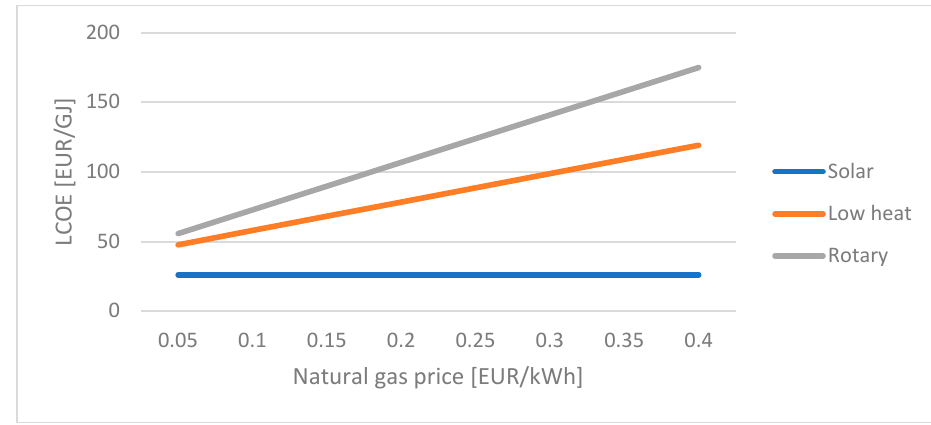
Figure 3. Sensitivity analysis on natural gas price.